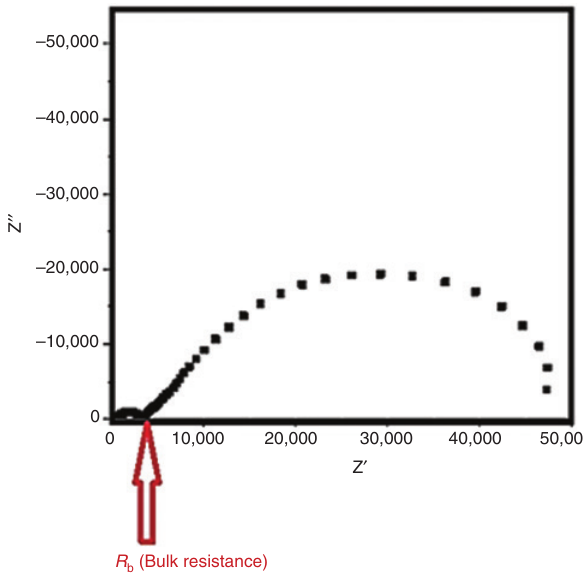
Figure 2: Cole-Cole plot for maximum conducting solid composite electrolyte.